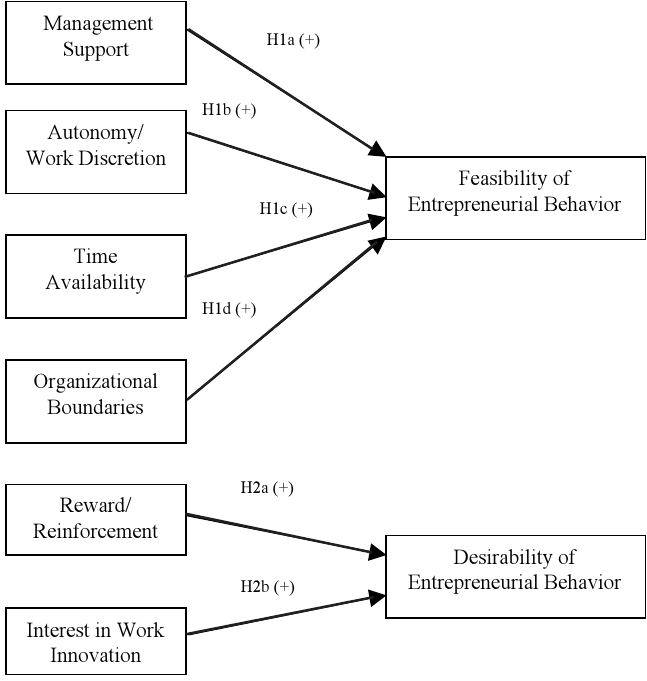
Figure 1. A Psychosocial Model of Corporate Entrepreneurial Potential